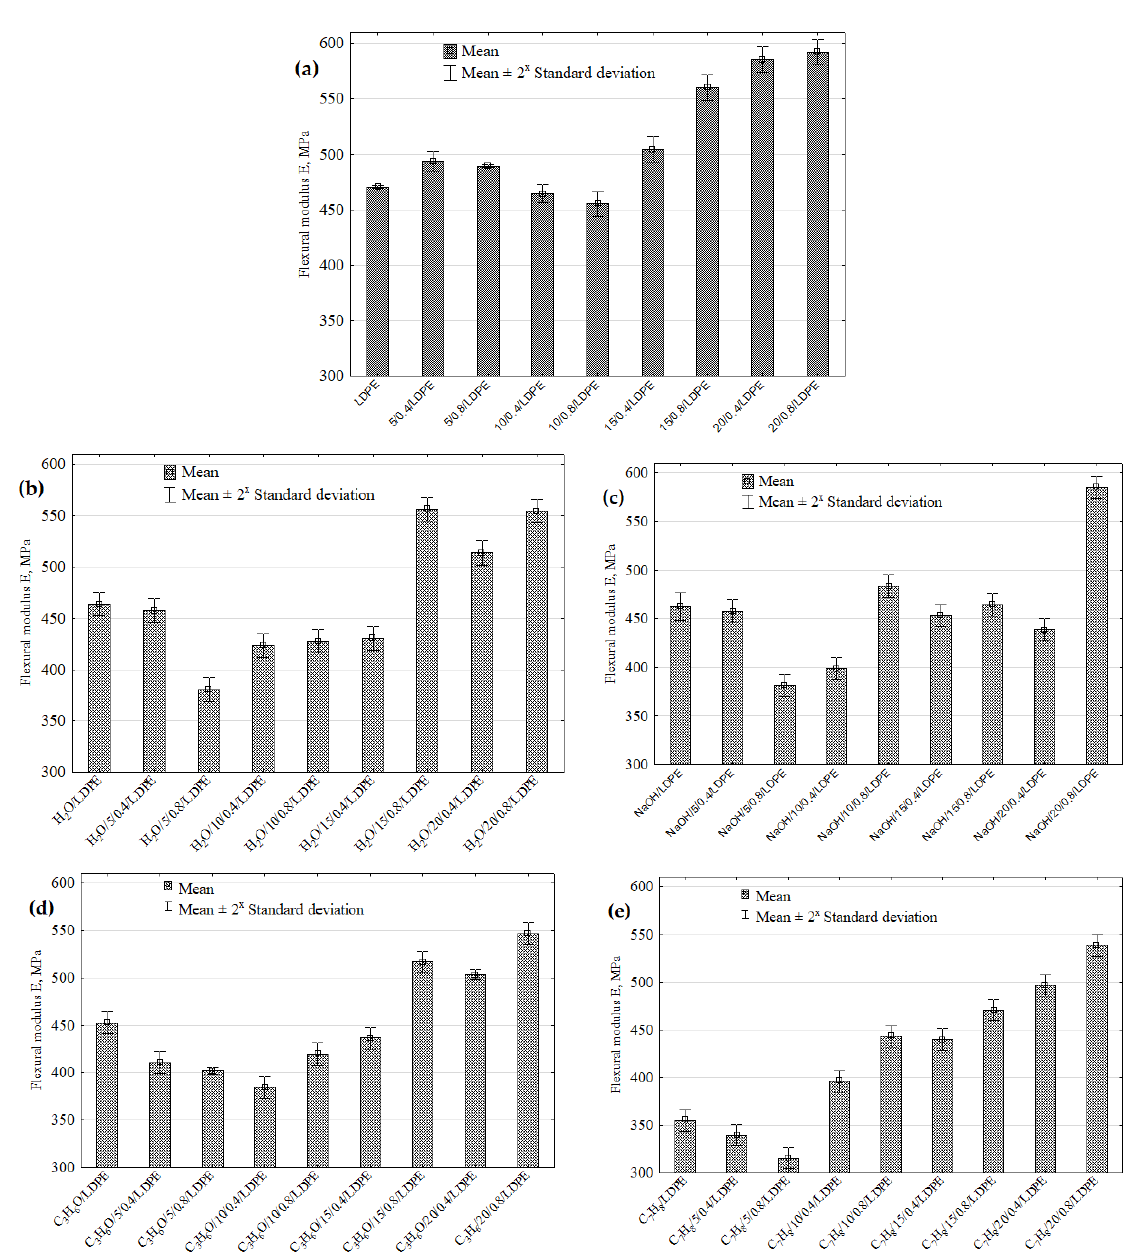
Figure 5. Flexural modulus of pure LDPE and LDPE with a natural filler versus different solvents: ( a ) reference samples, ( b ) distilled water, ( c ) NaOH solution, ( d ) acetone, ( e ) toluene. An analysis of the flexural modulus results reveals that this property decreases in the samples after the solvent immersion, irrespective of the solvent type (Figure 5b–e). The highest decrease in the flexural modulus amounting to 21.88% can be observed for the toluene-immersed samples with a 5 wt% filler content and a grain size of 0.6–0.8 mm (Fig- ure 4e). The multiple comparisons test showed significant differences between the flexural moduli of the following pairs of samples: H 2 O/5/0.8/LDPE–H 2 O/15/0.8/LDPE, H 2 O/5/0.8/LDPE–H 2 O/20/0.8/LDPE (Figure 5b), NaOH/5/0.8/LDPE–NaOH/10/0.8/LDPE, NaOH/5/0.8/LDPE–NaOH/20/0.8/LDPE